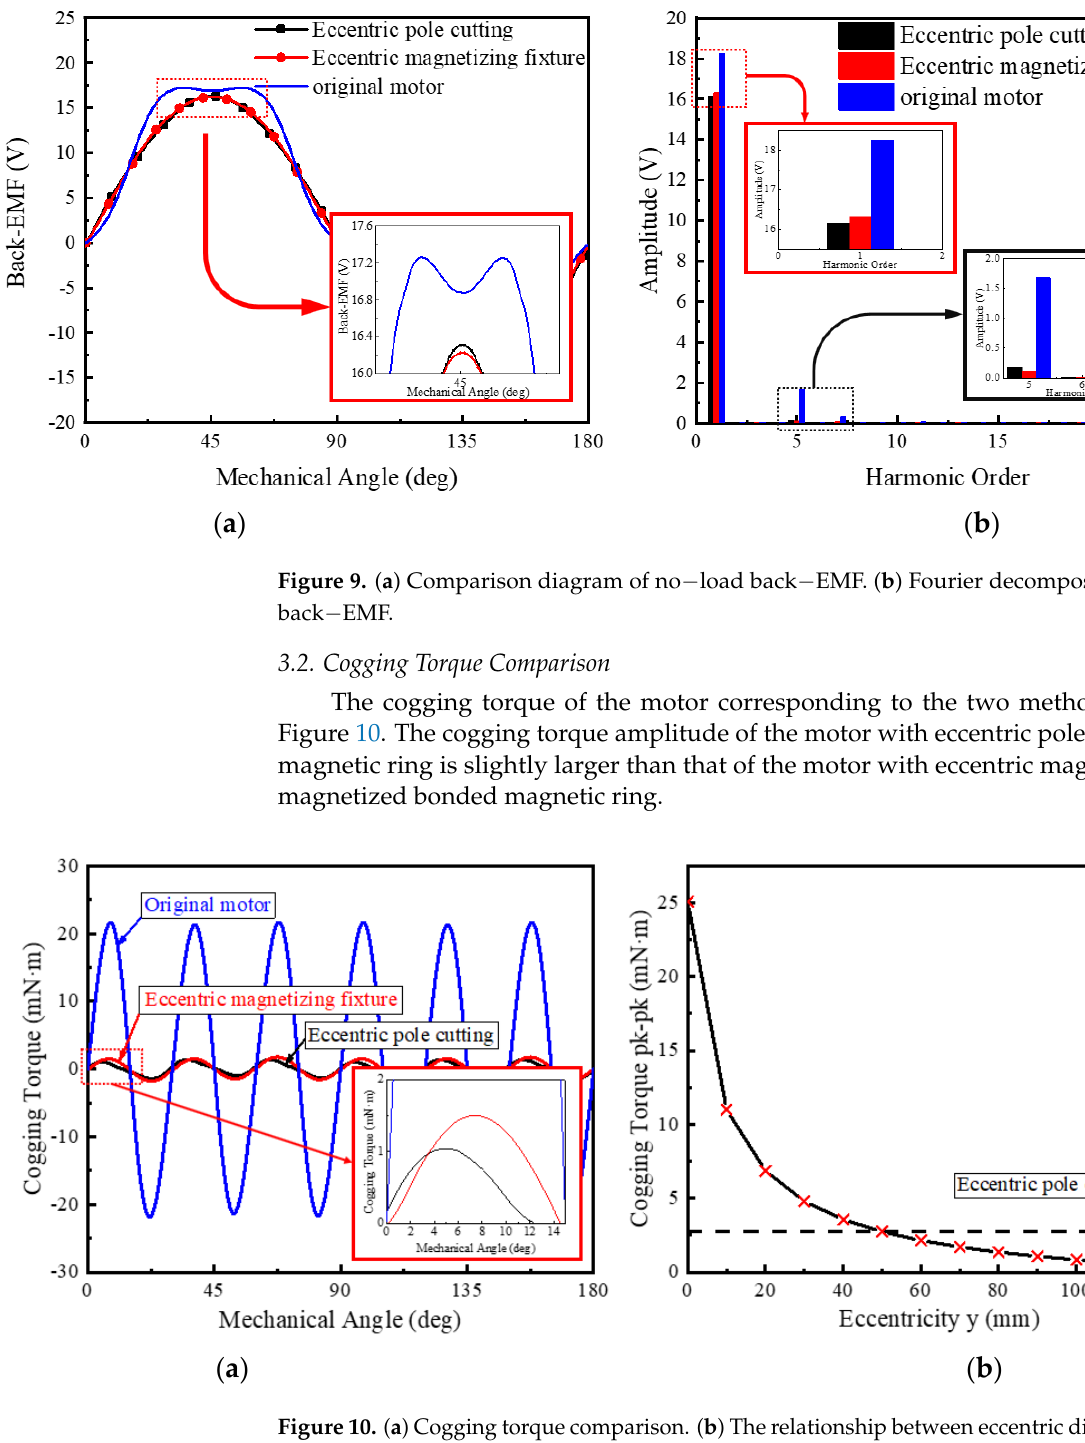
Figure 10. ( a ) Cogging torque comparison. ( b ) The relationship between eccentric distance of e-centric magnetizing fixture and peak − to − peak value of cogging torque.